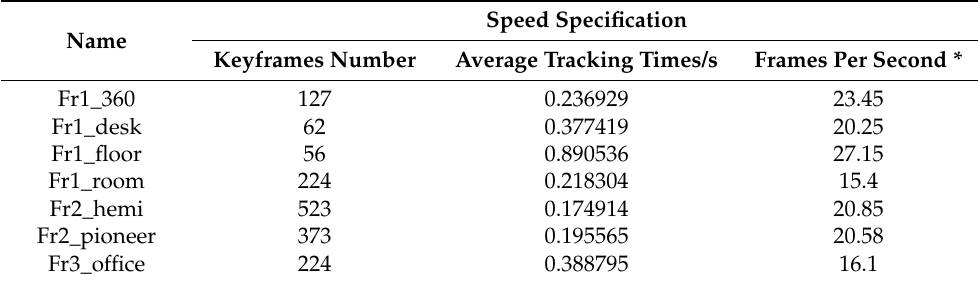
Table 2. SLAM execution speed evaluation.